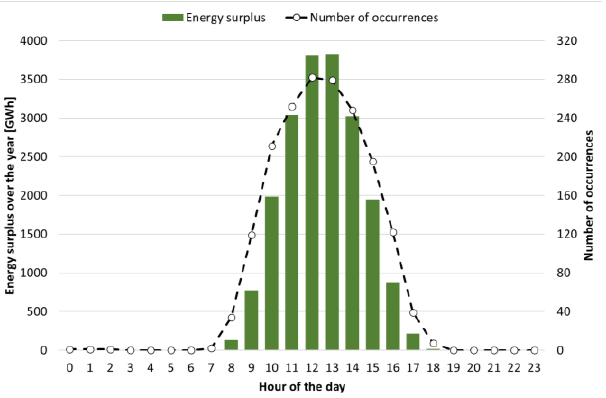
Figure 17. Distribution of hourly energy surplus over the year and number of occurrences in Case 2.